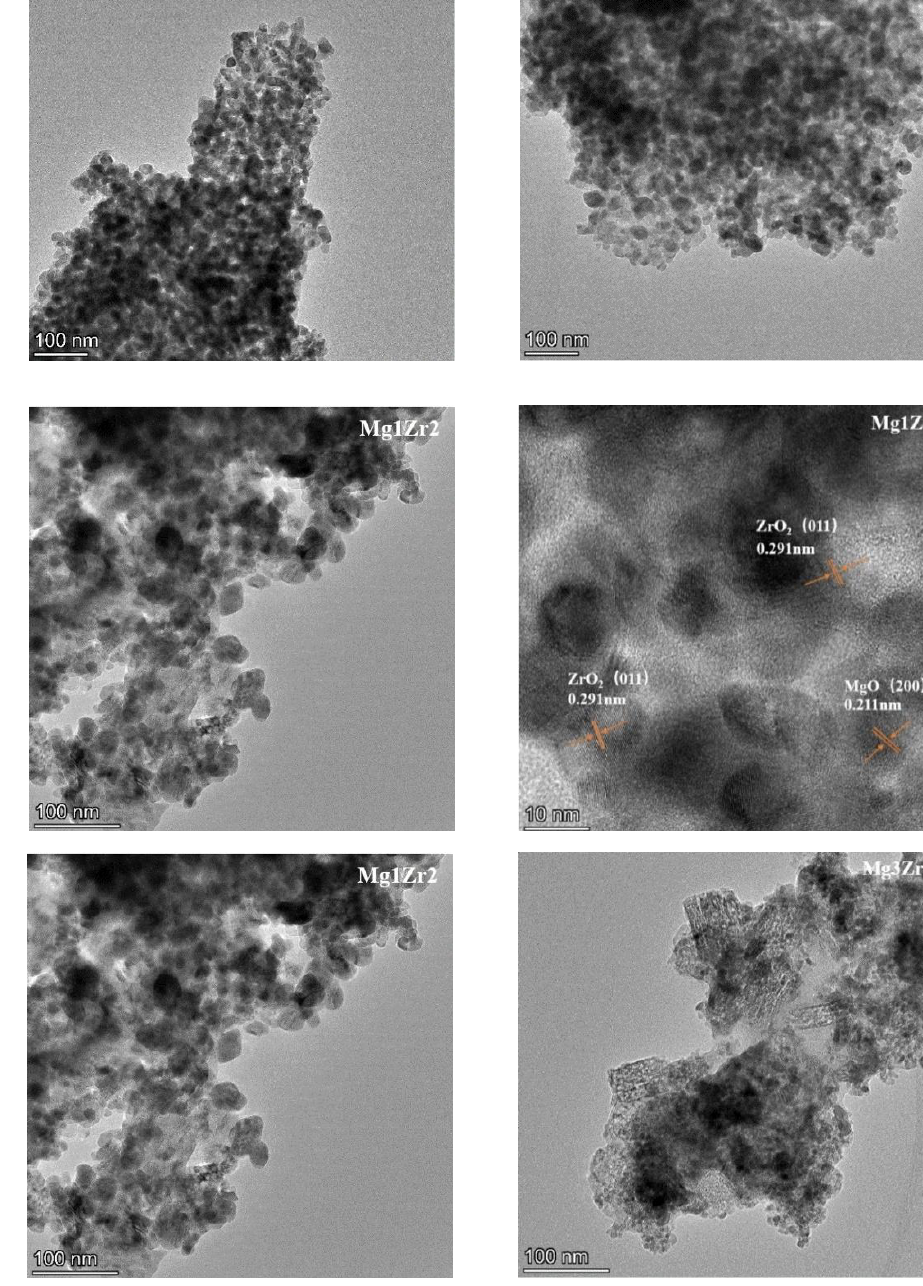
Figure 3. TEM images of Mg-Zr composite oxides with different Mg/Zr